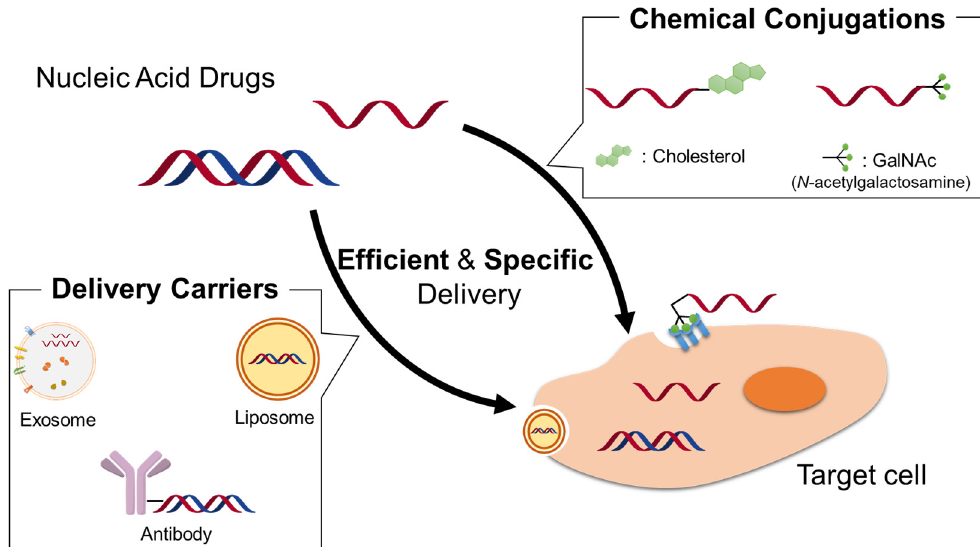
Figure 1. Schematic illustrations of delivery carriers and chemical conjugation strategies for nucleic acid drugs. Here shows typical delivery strategies: cholesterol conjugations [20–22], GalNAc conjugations [11–13,23–26], exosome [27–36], liposome [14–16,22,37–42], antibody [27,43–48].